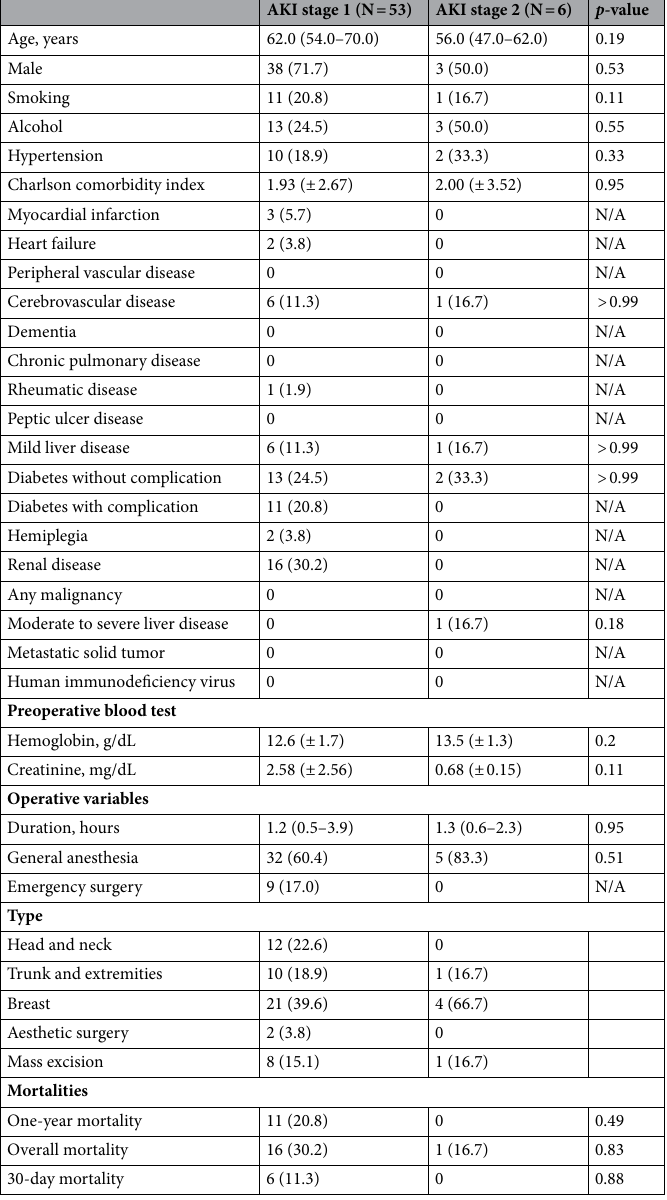
Table 3. Baseline characteristics and mortalities according to stages of postoperative acute kidney injury (AKI). Values are n (%), mean (± standardized difference), or median (interquartile